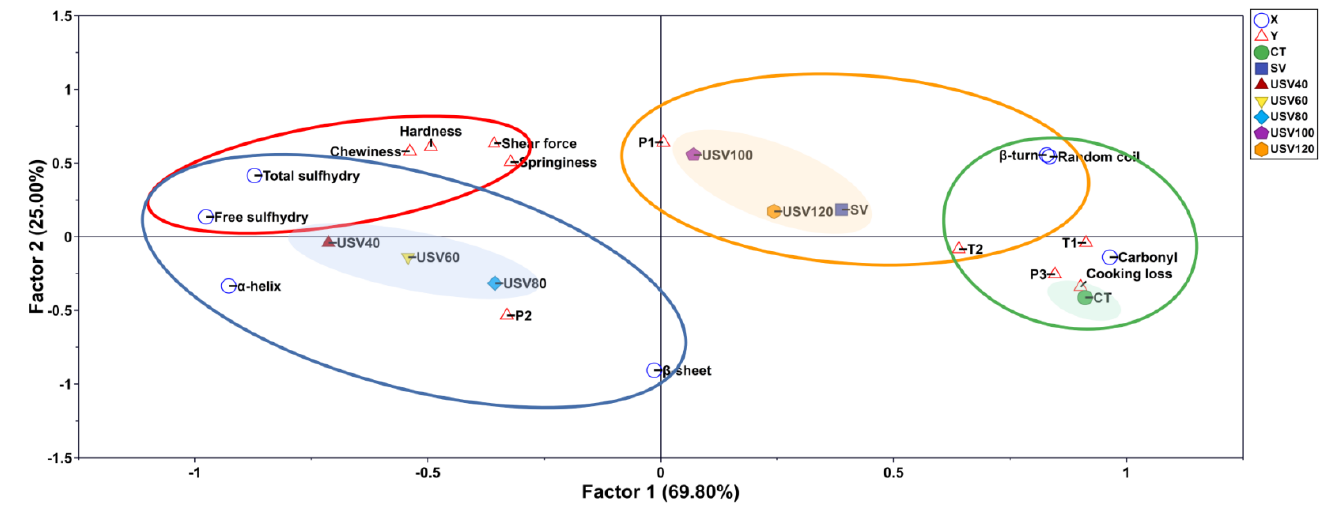
Figure 8. The correlation distribution of textural quality, water distribution, and protein characteristics of spiced beef under different thermal treatments. X: protein characteristics; Y: apparent quality indicators.